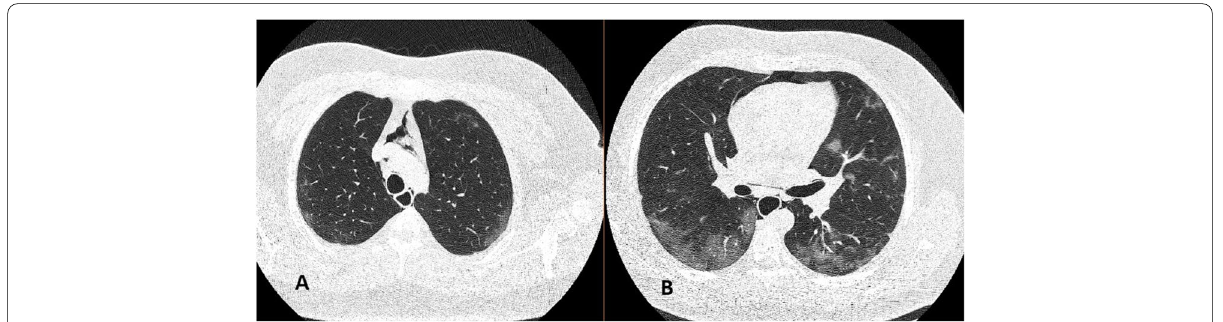
Fig. 2 Chest CT obtained at presentation to the ED in case 2, demonstrating mediastinal air ( A ). It shows bilateral ground-glass opacities and parenchymal consolidation ( A – B